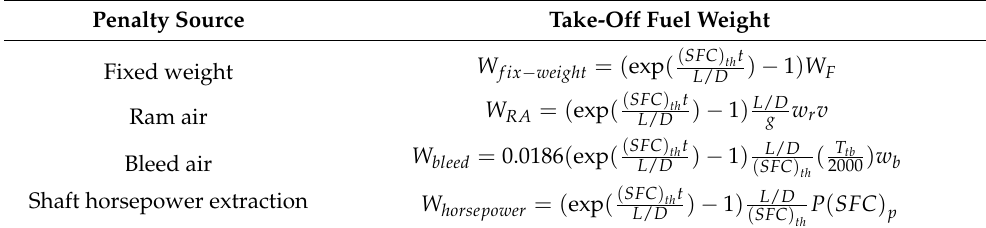
Table 4. Penalty sources and